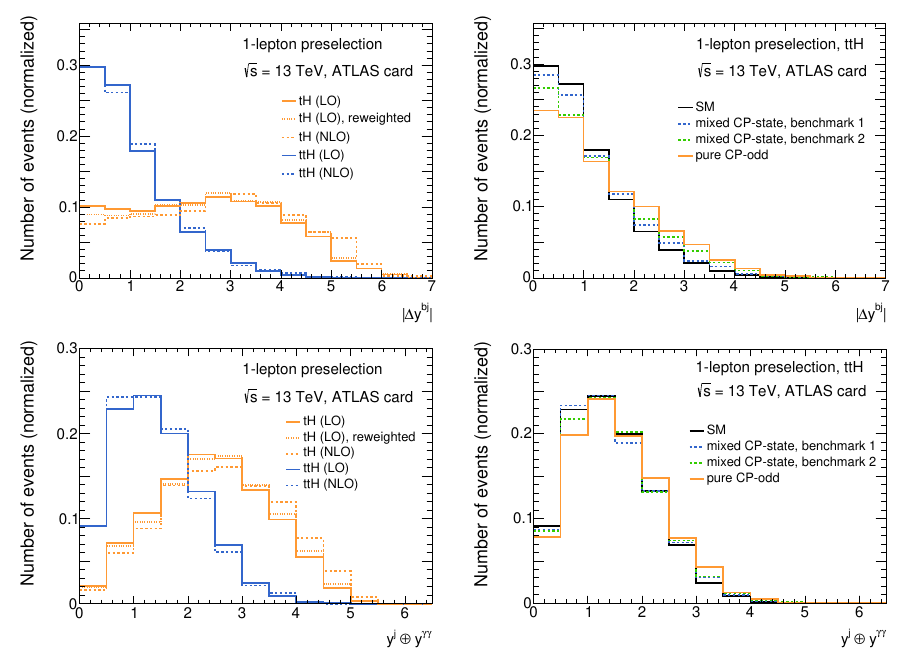
Figure 2: Upper left: | ∆ y bj | shape comparison of t ¯ tH (blue) and tH (orange) pro- duction. Lower left: Same as upper left panel, but y j ⊕ y γγ is shown. Upper right: | ∆ y bj | shape of t ¯ tH production comparing different Same as upper right panel, but y j ⊕ y γγ is